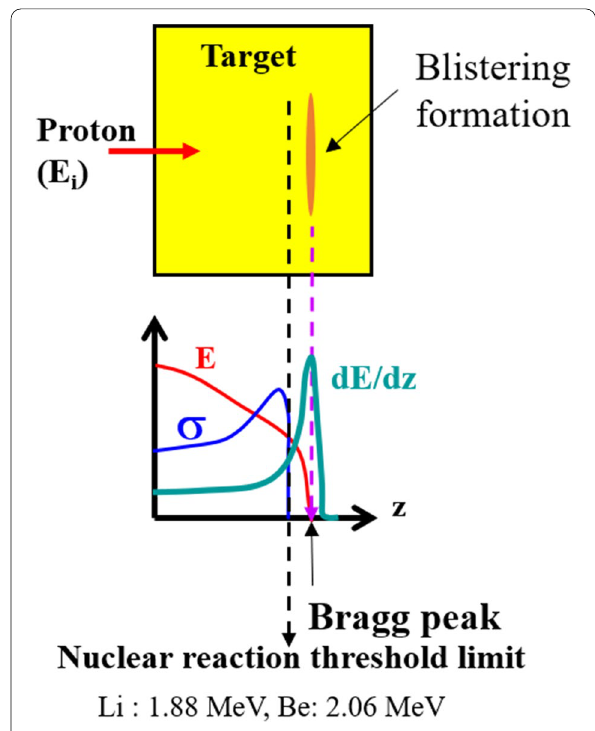
Fig. 4 The relations in the target material between the Bragg peak and energy required for nuclear reactions